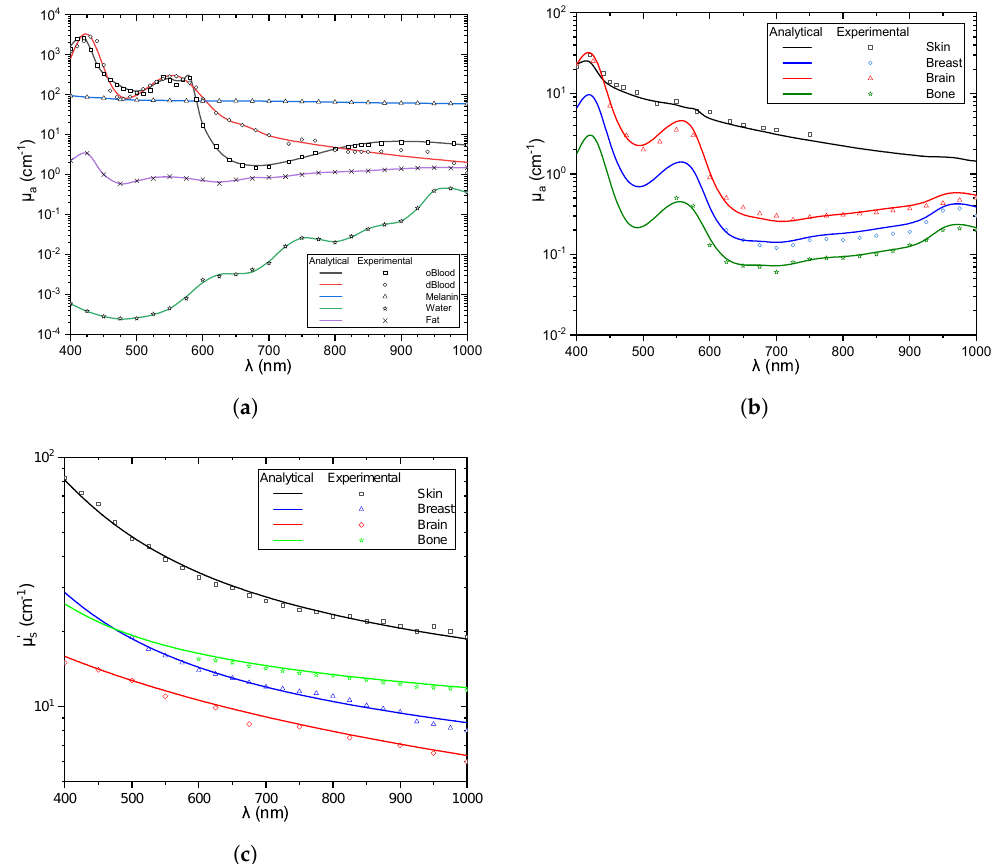
Figure 2. Attenuation coefficients of complex tissues and their constituents as a function of λ . ( a ) Absorption coefficient of tissue constituents. ( b ) Absorption coefficient of complex tissues. ( c ) Reduced scattering coefficient of complex